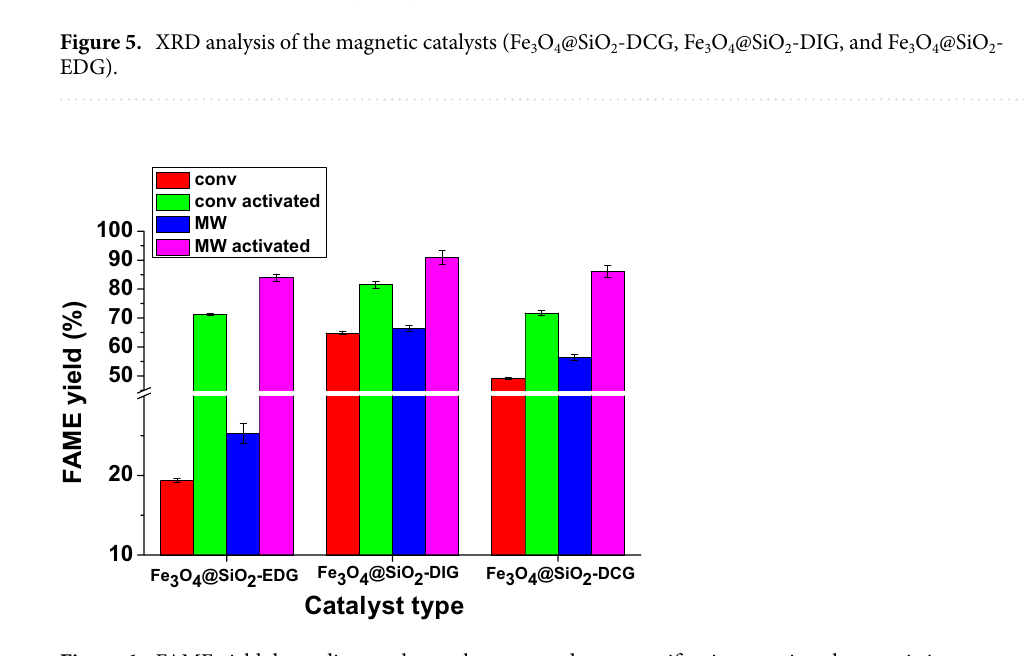
Figure 6. FAME yield depending on the catalyst type and transesterification reaction characteristics (conventional or MW assisted) and on the activation of the catalyst (temperature 80 °C; reaction time 180 min; molar ratio oil/MeOH 1/6; 3.5% weight ratio catalyst vs. oil; 780